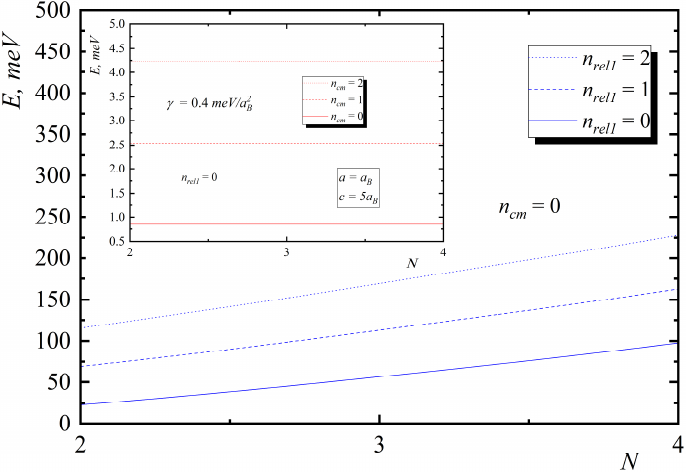
Figure 9. Dependences of the energies on the number of particles for relative motion (insert – center of mass motion).